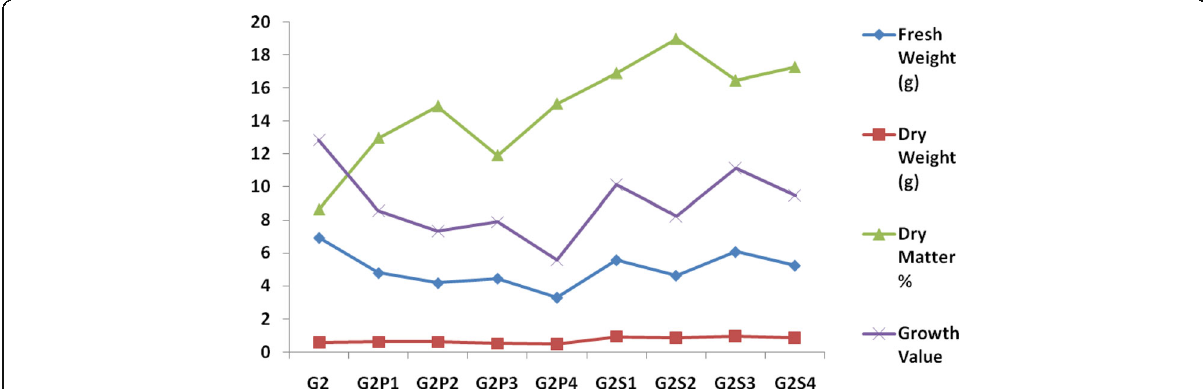
Fig. 4 Callus growth measurements in the second harvest. G2 control = 4 mg/l TDZ, G2P1 = 4 mg/l TDZ + 2 mg/l PA, G2P2 = 4 mg/l TDZ + 3 mg/l PA, G2P3 = 4 mg/l TDZ + 4 mg/l PA, G2P4 = 4 mg/l TDZ + 5 mg/l PA, G2S1 = 4 mg/l TDZ + 34.5 mg/l SA, G2S2 = 4 mg/l TDZ + 69 mg/l SA, G2S3 = 4 mg/l TDZ + 103.5 mg/l SA, G2S4 = 4 mg/l TDZ + 138 mg/l